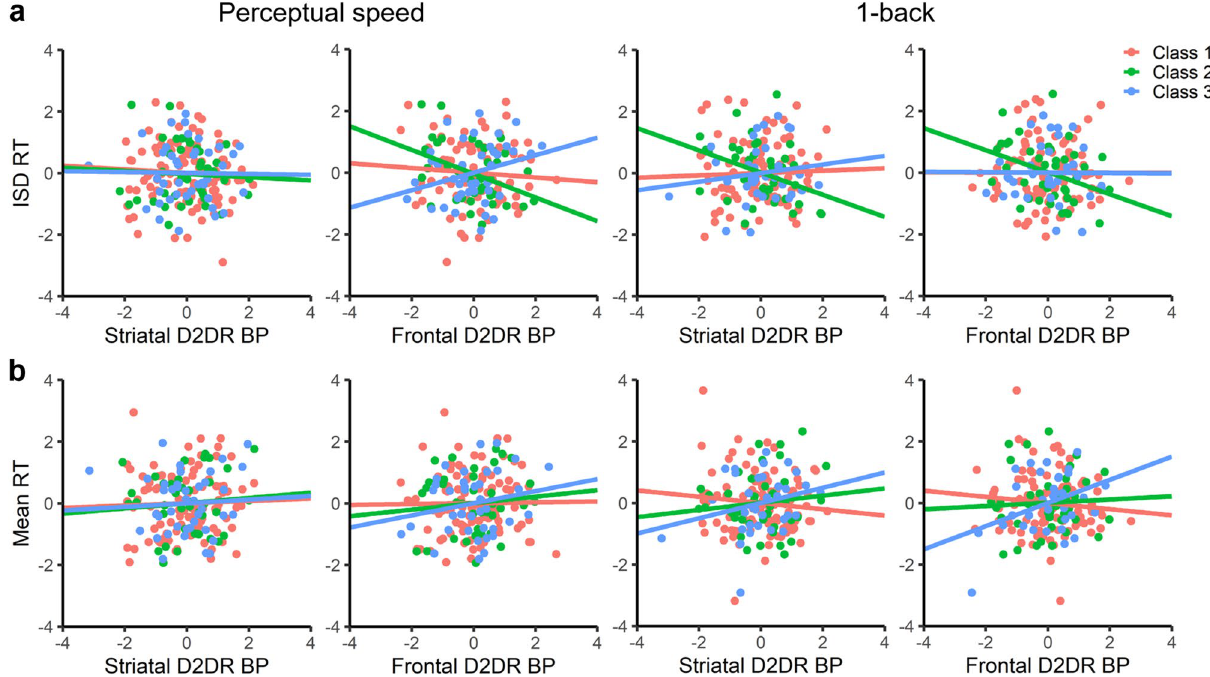
Figure 2. Relationships between fronto-striatal D2DR availability and intra-individual variability in reaction time (RT) ( a ), and mean RT ( b ), colored by subgroup membership (Class 1 = high cognition, high D2DR availability, Class 2 = low cognition, low D2DR availability, Class 3 = low cognition, high D2DR availability 60 ). Figures display standardized residuals of each variable after controlling for sex, education, and mean RT ( a ), or sex and education ( b ) within each